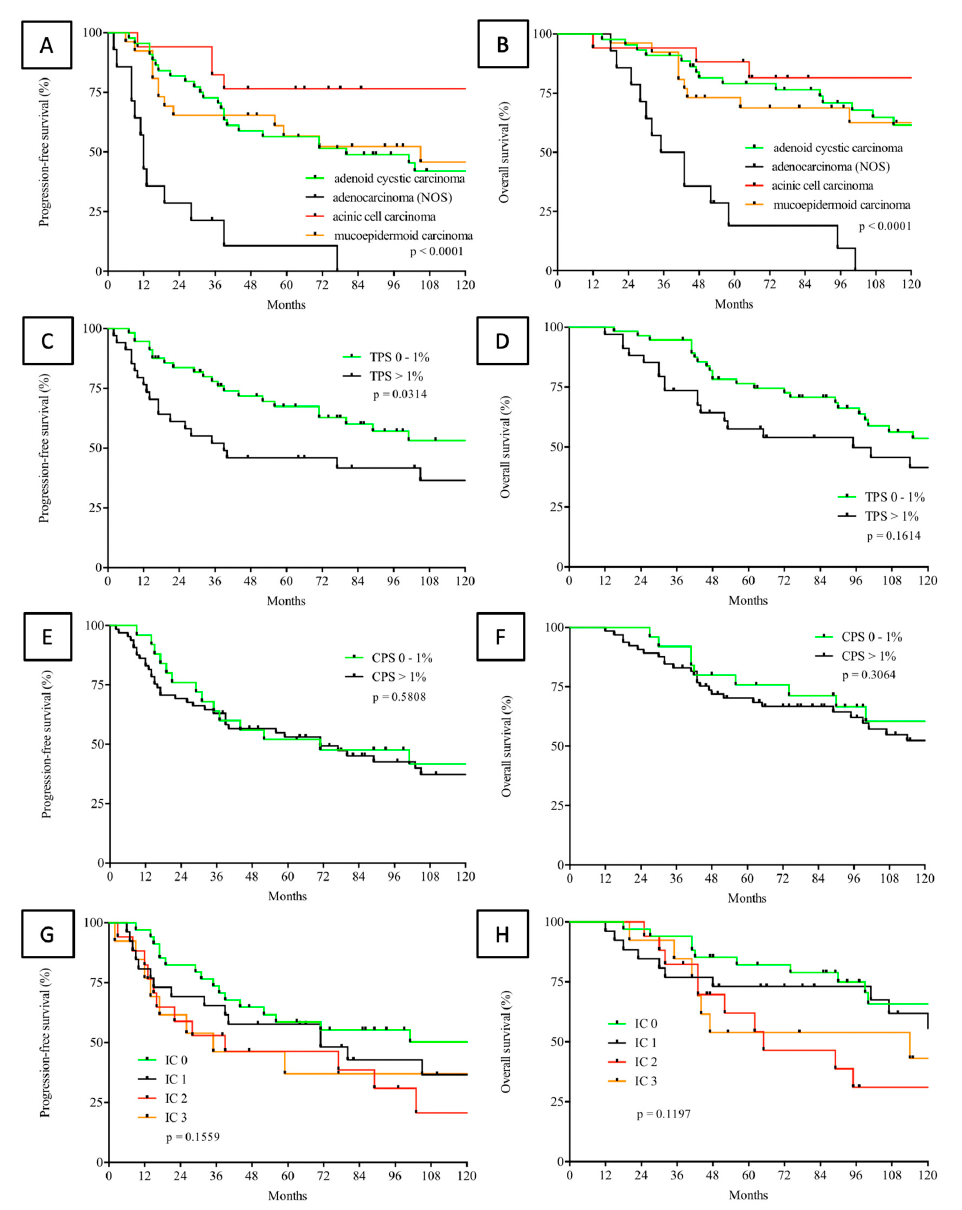
Figure 4. Comparative Kaplan-Meier analysis over all entities of salivary gland carcinomas included